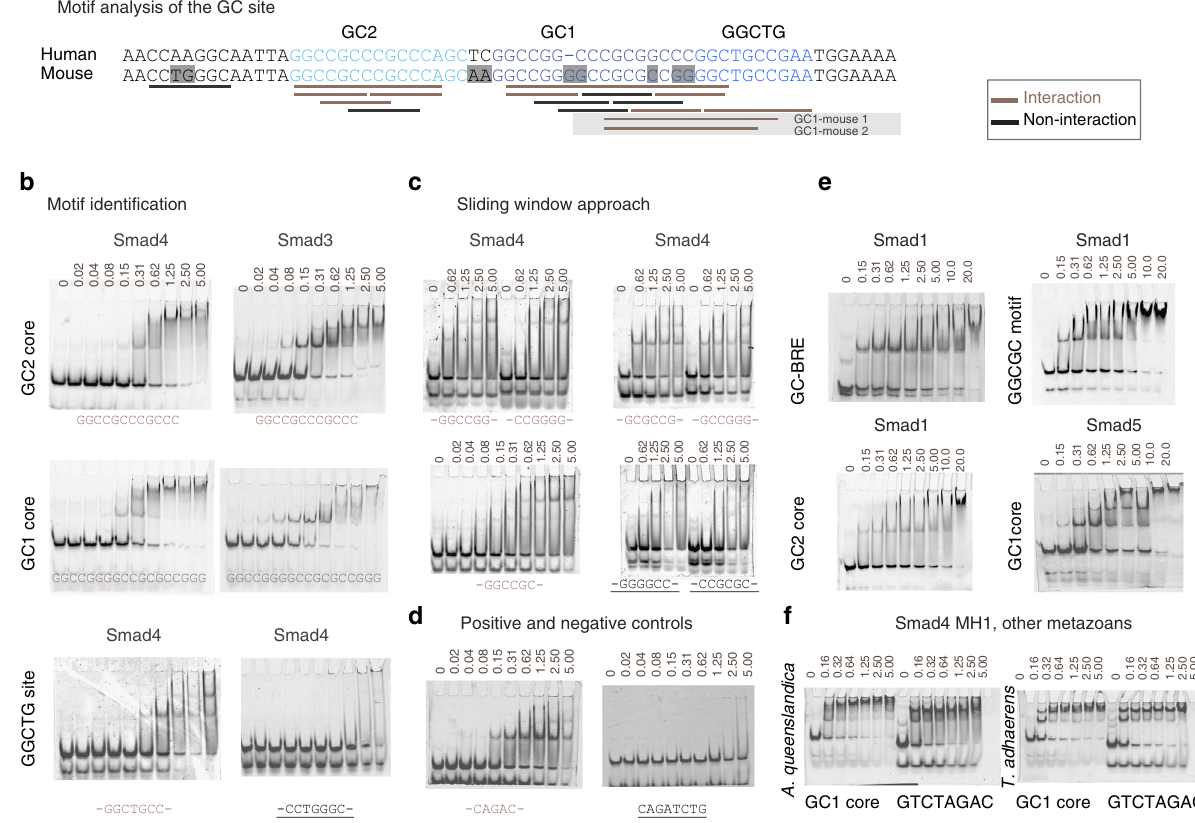
Fig. 2 Identi fi cation of speci fi c/unspeci fi c GC binders using EMSA experiments. a Human and mouse comparison of the GC site (differences are highlighted in gray in the mouse sequence). Fragments of the GC site used for the EMSA assays are represented as bars under the sequences. Nanomolar af fi nity interacting fragments are shown as brown bars and sites that do not interact or that they do so in the micromolar range (considered unspeci fi c) are in black. b Three regions of the GC site including the GC1 core, GC2 core, and the GGCTG site analyzed using EMSA assays. Experiments are performed using human Smad4 and Smad3 MH1 domains as indicated. Protein concentrations are shown on top of the EMSA (micromolar concentrations). Abbreviations for the DNA oligonucleotides referred to the binding motifs are shown and colored according to their interaction properties: brown for binders, black for non-binders. c Exhaustive analysis of the different motifs using EMSA experiments. The complete list of oligonucleotides is shown in Supplementary Table 1. Abbreviations for the DNA oligonucleotides referred to the binding motifs are shown and colored according to their interaction properties as in b . d Positive and negative binding controls using the CAGAC and CAGAT sites, respectively. e EMSAs showing the interaction of Smad1 and Smad5 to different DNA regions, showing af fi nities similar to those of Smad3 and Smad4. The SBE (GTCTAGAC) and GC-BRE sites (GGCGCC) were used as positive controls. Additional EMSAs are included in Supplementary Fig. 2a. f EMSAs corresponding to the Smad4 MH1 domains of sponge Amphimedon queenslandica and the placozoa Trichoplax adhaerens illustrating that binding to the GC sites is conserved in metazoans. The oligos used in these cases correspond to the GC1 core and to the canonical GTCT site